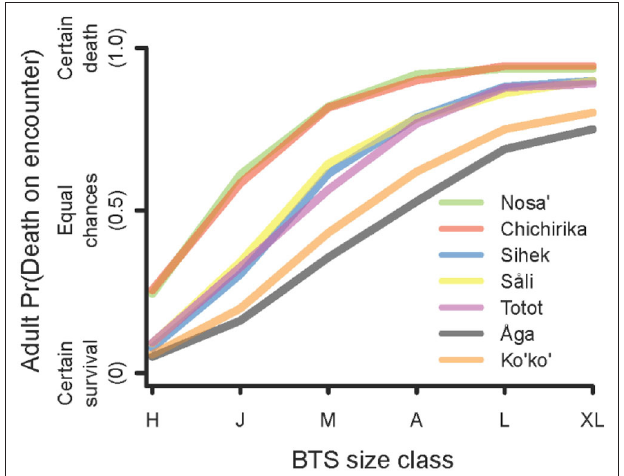
FIGURE 3 | Risk ranking (probability of death) for an adult bird in an encounter with a BTS for each snake size class: H, hatchling (350–700mm snout-vent length); J, juvenile (700–900); M, mature (900–1050); A, adult (1050–1200); L, large adult (1200–1500); XL, extra-large adult ( > 1500).